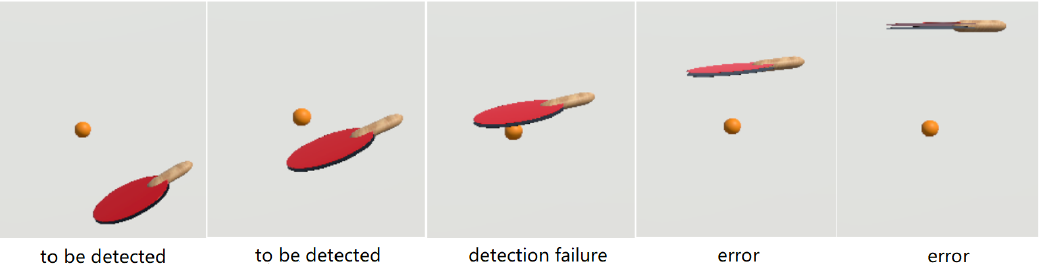
Figure 2. Interaction relationship between user and devices.